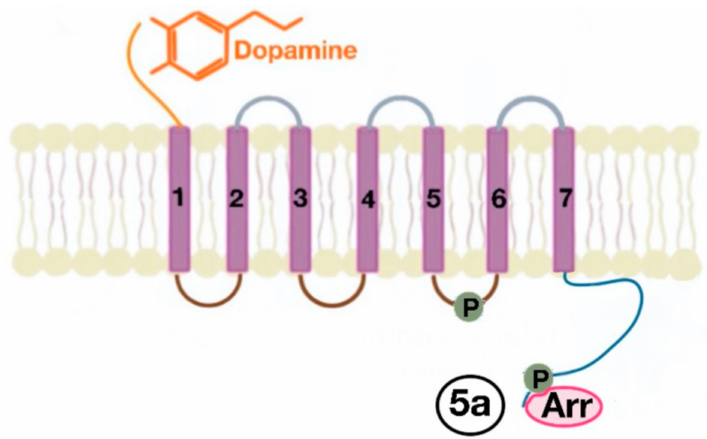
Figure 5. The phosphorylation of amino acids in the third intracellular loop of the transmembrane segments and C-terminal tail leads to the activation of β -arrestins (5a).